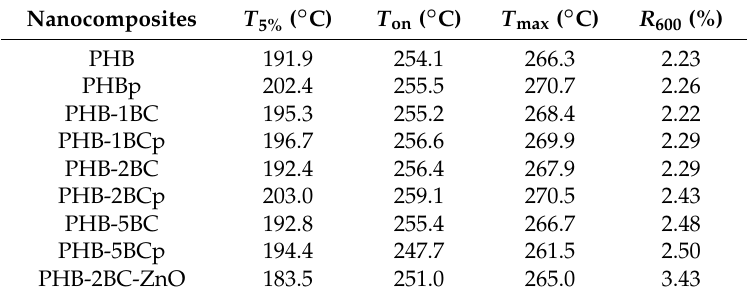
Table 1. TGA results for PHB nanocomposites before and after the plasma treatment.